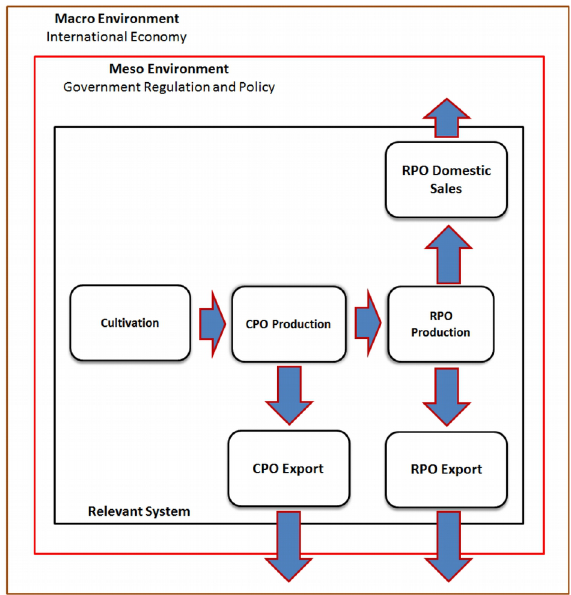
Figure 2. Indonesian Palm Oil Industry Value